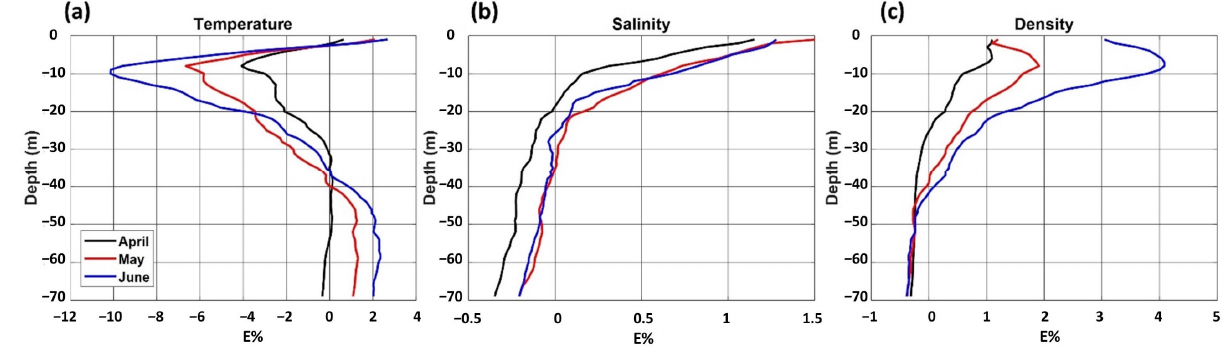
Figure 10. Percentage error along the water column between T ( a ), S ( b ) and ρ ( c ) simulated by the CROM model and observed at the LTER ‐ MC sampling site for April, May and June 2016. Table 10. Maximum error difference between observed and simulated hydrological data.